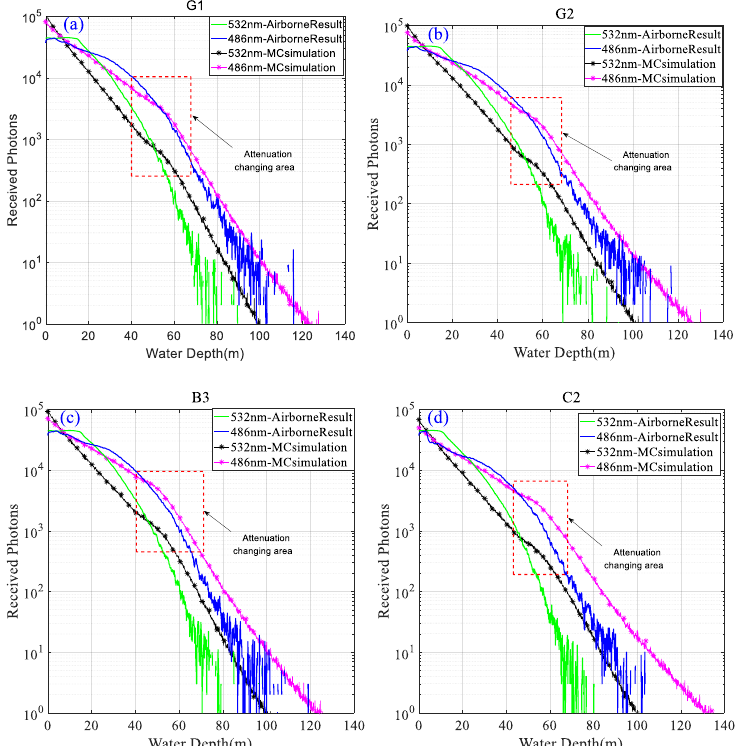
Figure 15. ( a – c ) Comparison between the simulation results and the airborne results at altitude of 2000 m; ( d ) comparison between the simulation results and the airborne results at altitude of 2500 m.